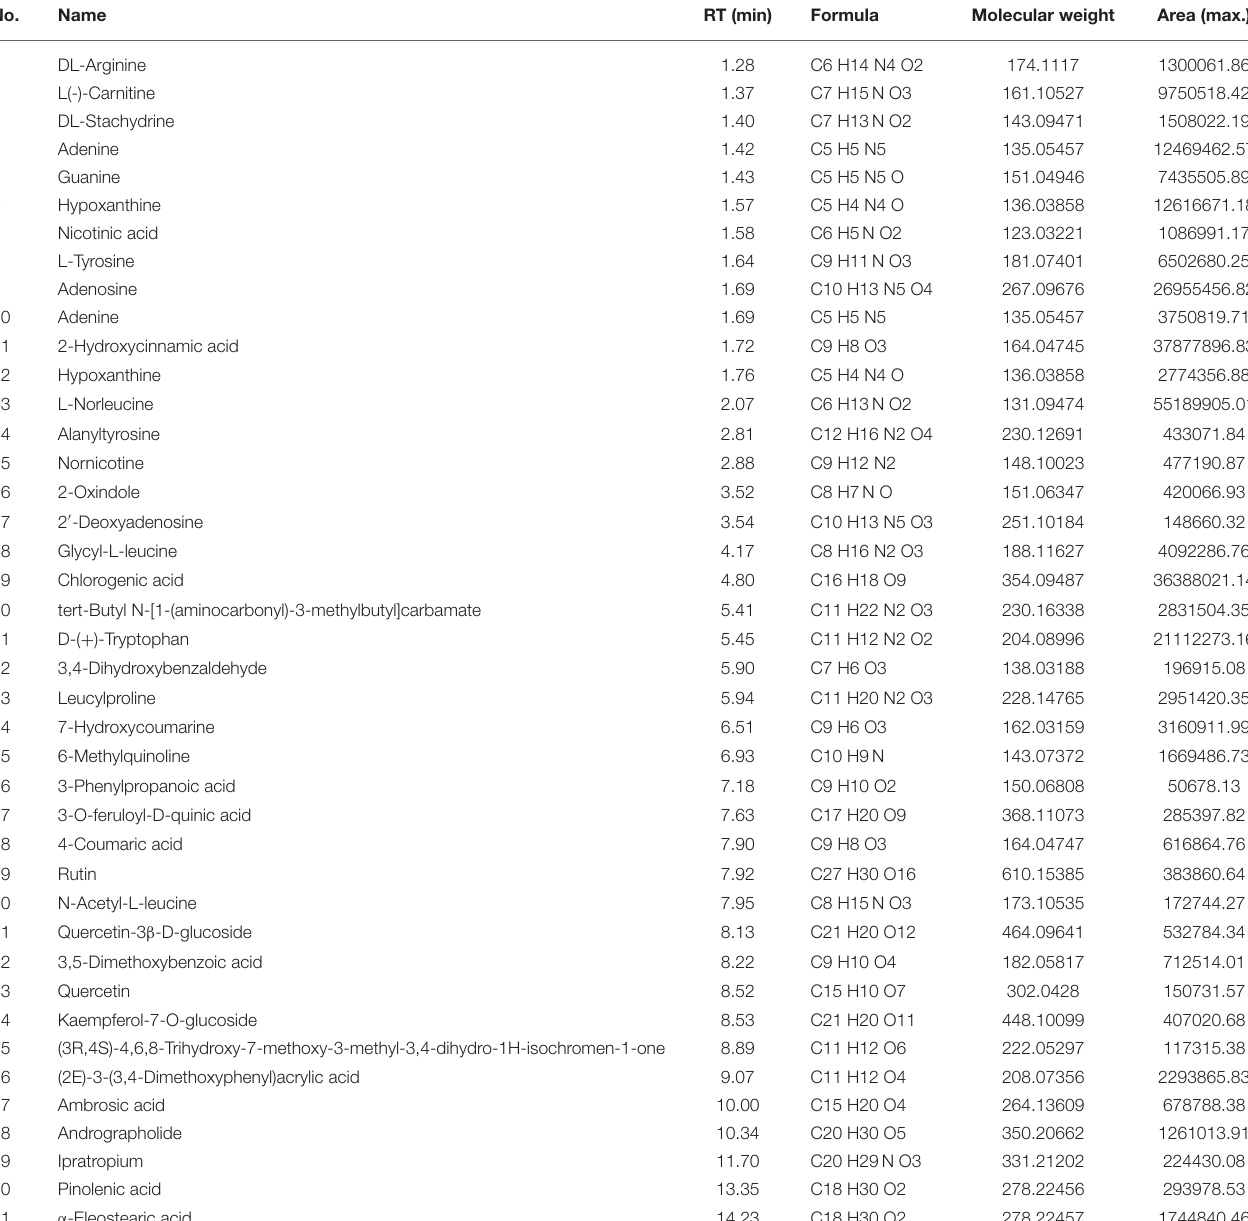
TABLE 1 | Major chemical constituents identified in